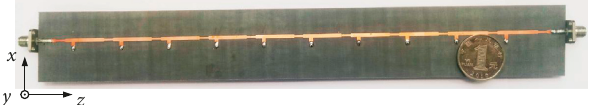
x zy Figure 2: Prototype of the proposed miniaturized periodic MLWA with shorting pins.